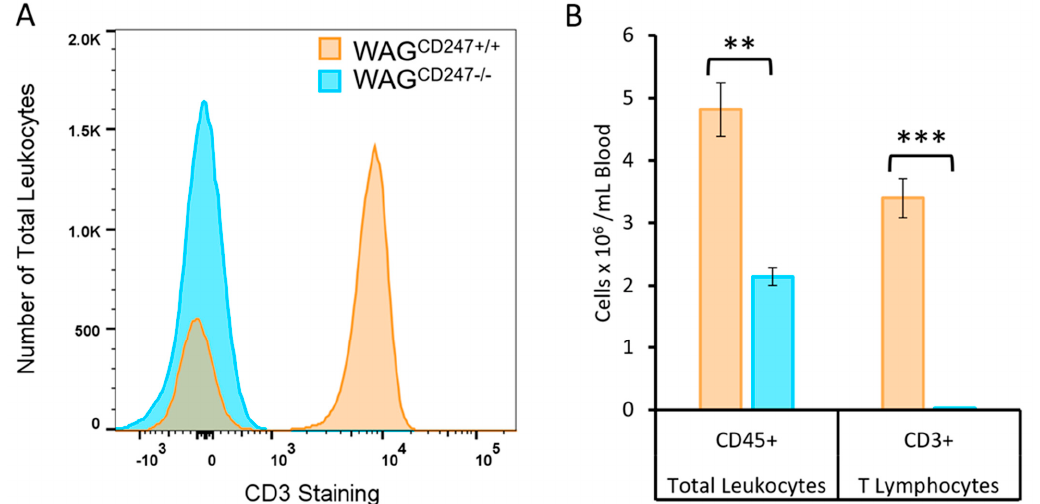
Figure 4. Effective knock down of circulating T lymphocytes in WAG CD247-/- rats. ( A ) Representative histogram of peripheral blood mononuclear cell showing CD3 + staining cell counts gated on CD45 + total leukocytes demonstrating depletion of CD3 + T lymphocytes in circulation of male WAG CD247-/- rats at 5–6 weeks of age. ( B ) Summary of the numbers of CD45+ total leukocytes and CD3 + T lym- phocytes in circulation of WAG CD247-/- compared to their wild-type WAG littermate controls. CD3 + lymphocytes were present at very low levels in WAG CD247-/- rats. Data are mean + SEM, n = 3–5 per group. ** = p < 0.01 vs. wild-type. *** = p < 0.001 vs. wild-type.